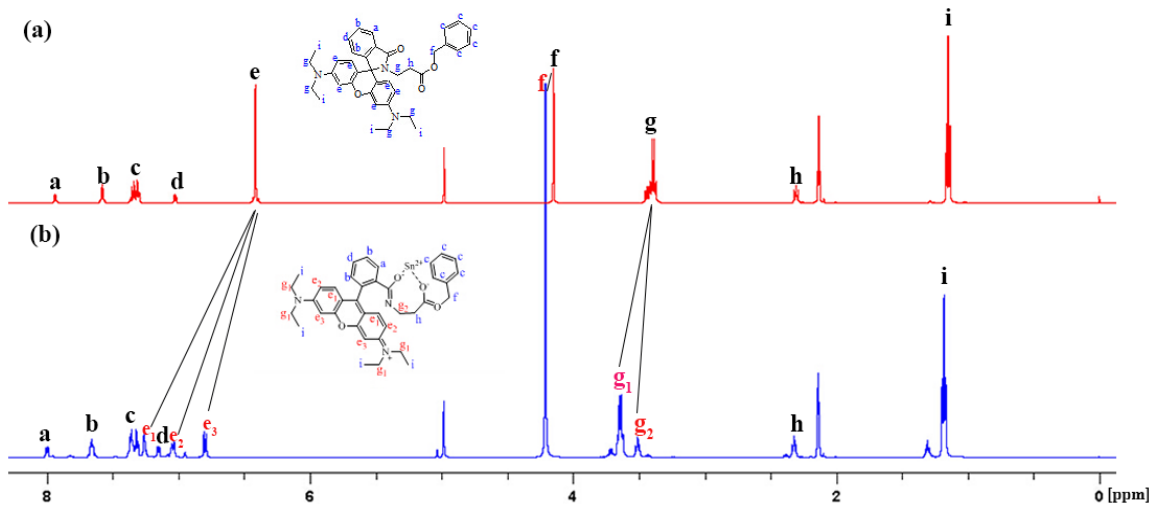
Figure 10. 1 H-NMR spectra (500 MHz, 298 K, acetone- d ( b ) RBAP + 1 equiv. Sn 2+ .